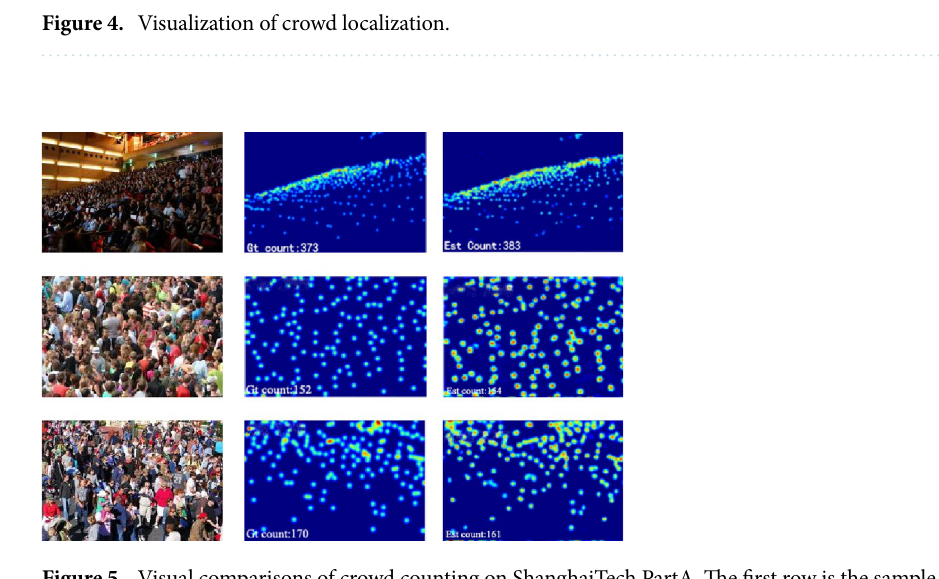
Figure 5. Visual comparisons of crowd counting on ShanghaiTech PartA. The first row is the sample images. The second row is the ground truth. The 3rd rows correspond to the estimated density maps from